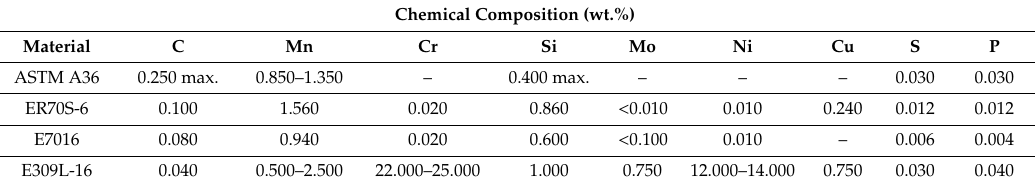
Table 2. Chemical compositions of the considered materials in this study.